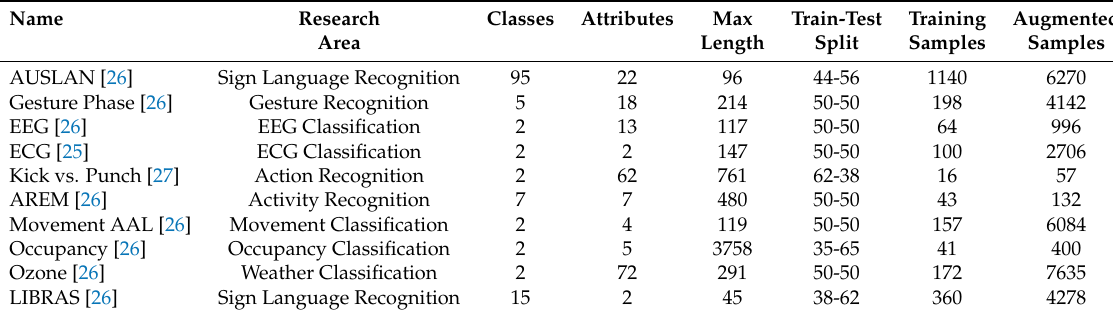
Table 1. Time series benchmark datasets used in